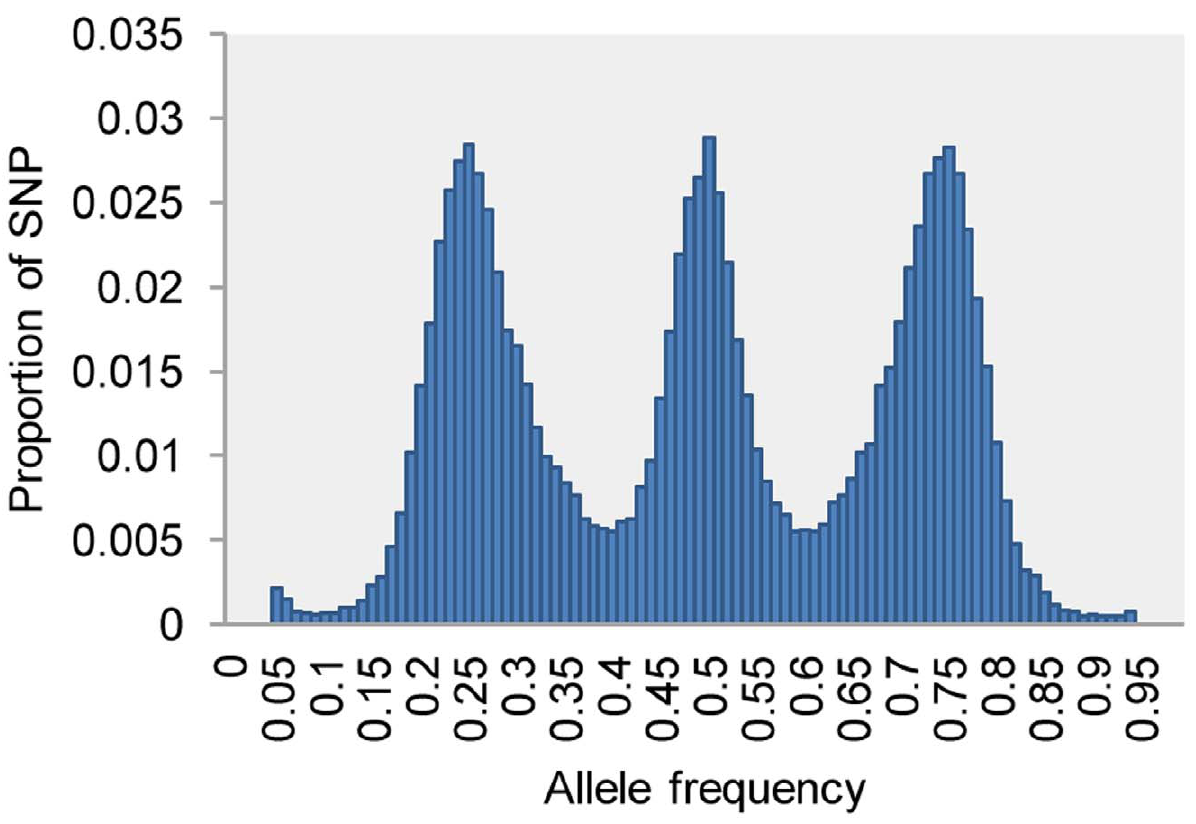
Figure 3. Allele frequency of 50,000 SNPs (call rate . 0.8) in the full-sib F1 population (n=130) of upland tetraploid switchgrass, showing the classic signature of a cross between two heterozygous